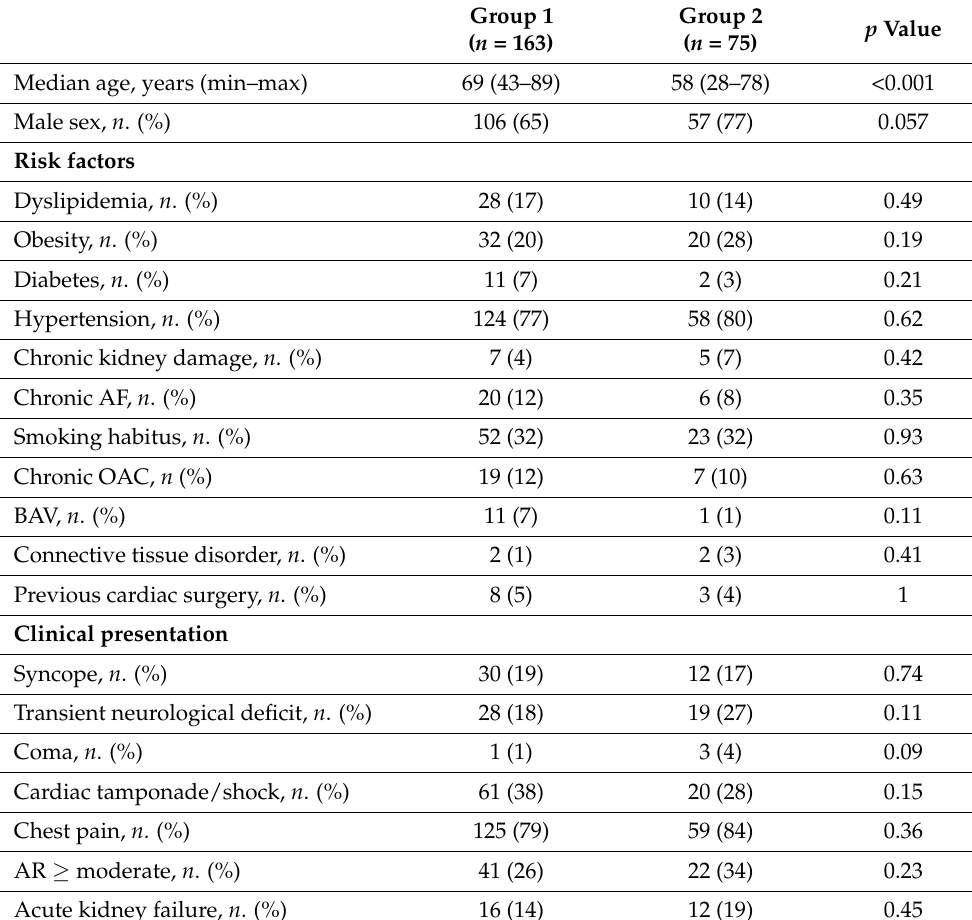
Table 1. Main preoperative patient